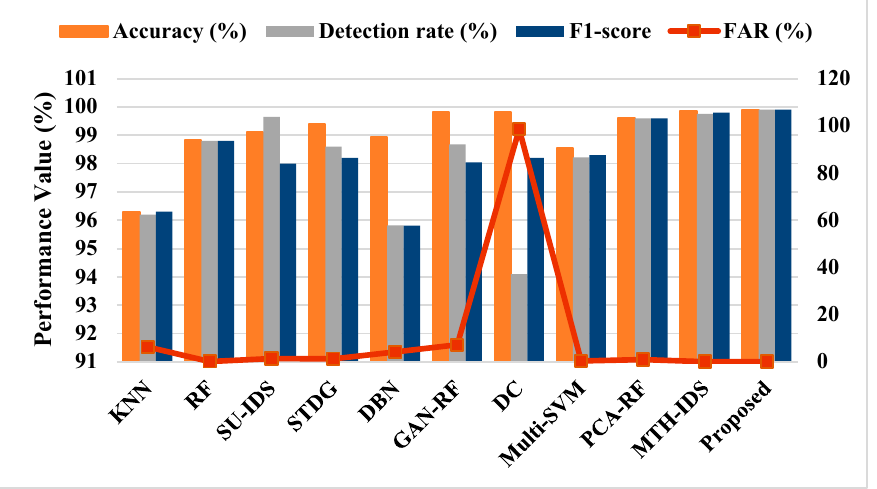
Figure 21. Performance comparative analysis using dataset 3.